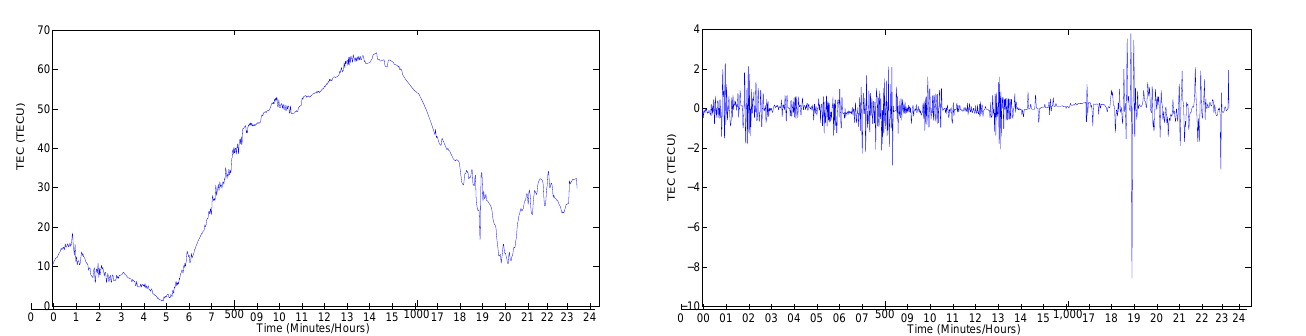
Figure 1. A typical time series plot for TEC measured at Lagos for 20 November 2011.